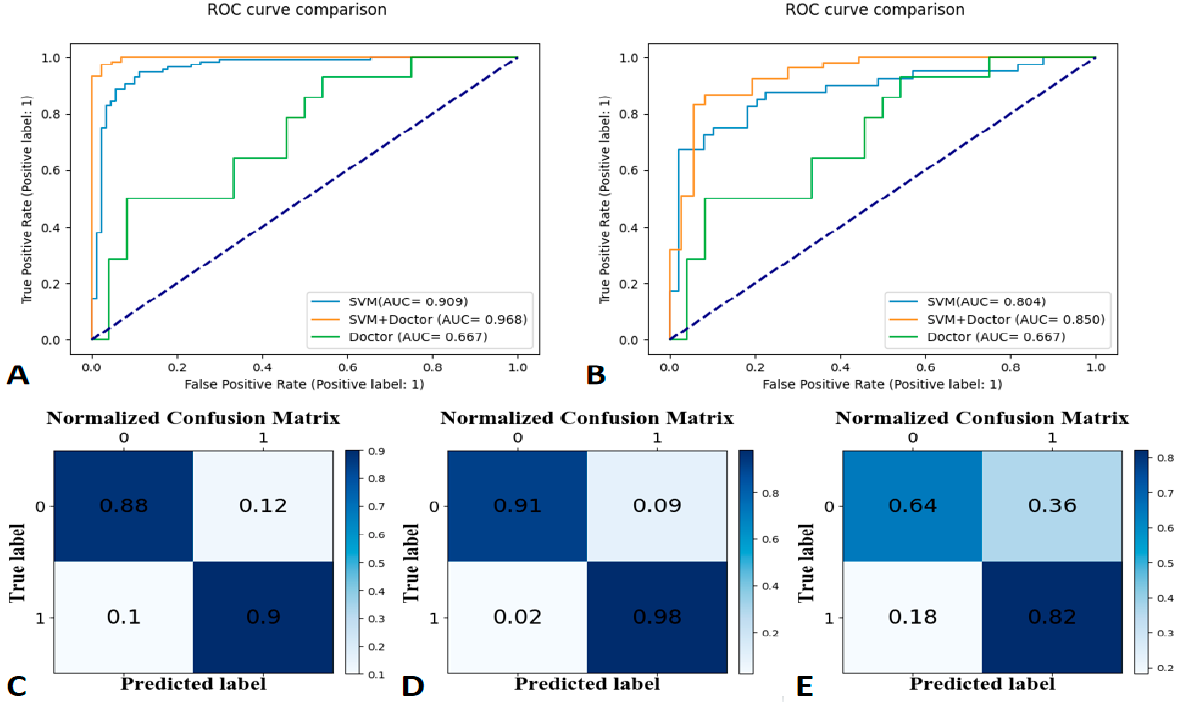
Figure 5. Receiver operating characteristic (ROC) curves for the training set at 90-day labels ( A ), ROC curves for the testing set at 90-day labels ( B ), a confusion matrix of the Support Vector Machine ( C ), human–model collaboration ( D ), and radiologist’s interpretation ( E ) for the testing set (90-day label). Table 3. Performances of the radiomics-based model, radiologist’s interpretation, and human– model collaboration for the testing set in predicting rib fracture at 90 days.